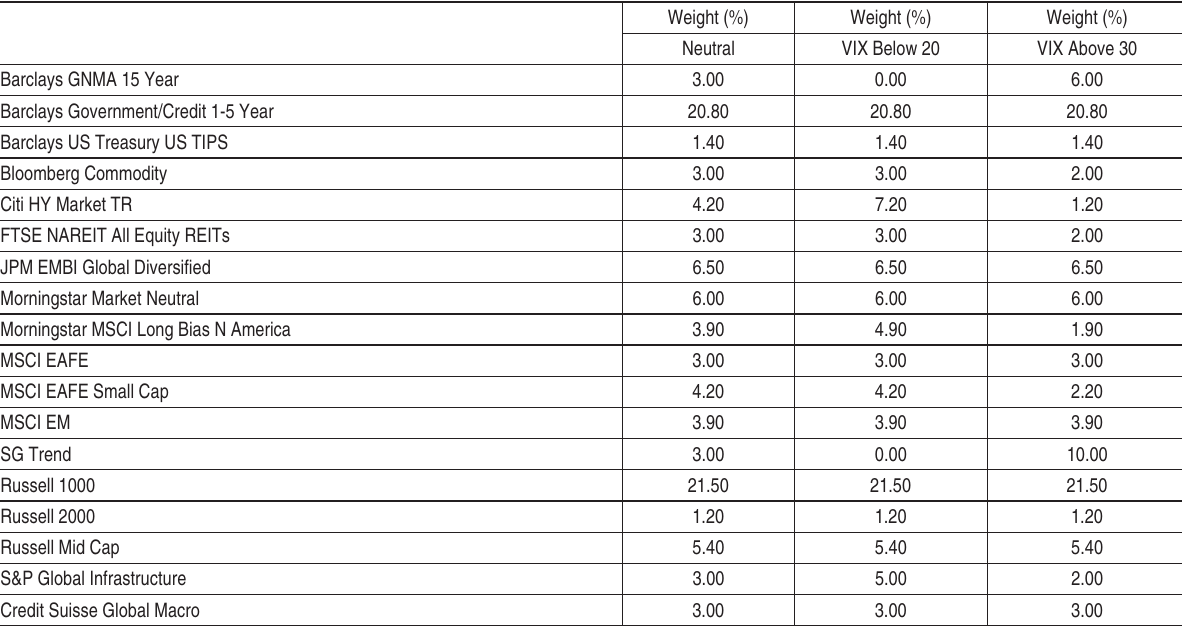
Table 2. Asset allocation vs the VIX